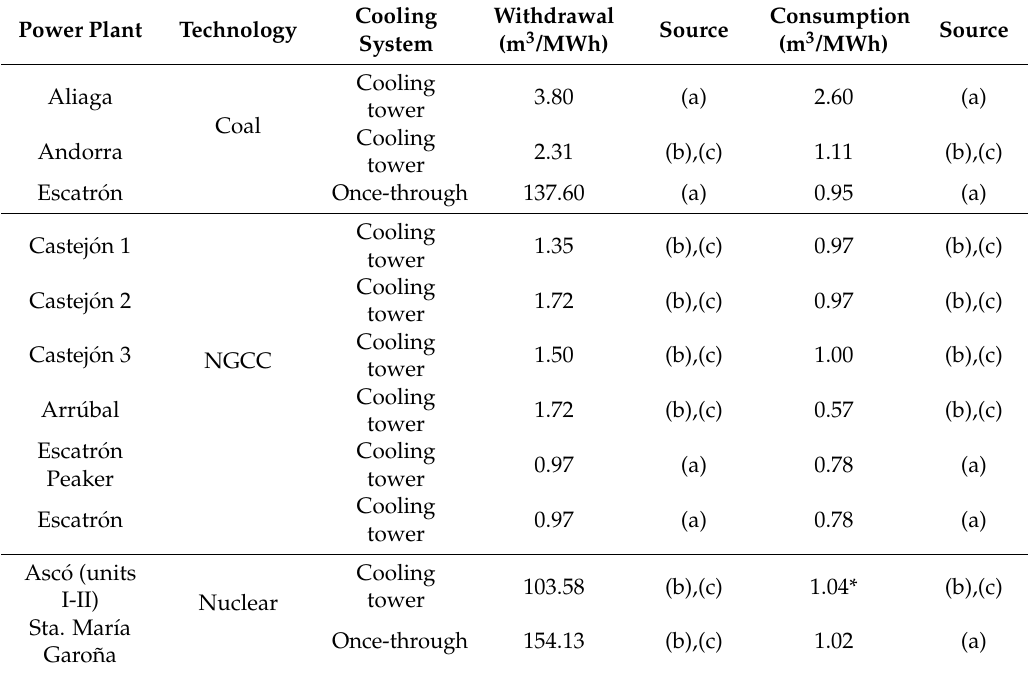
Table 2. Average water use factors for thermal power plants by type of technology and cooling system in the Ebro River